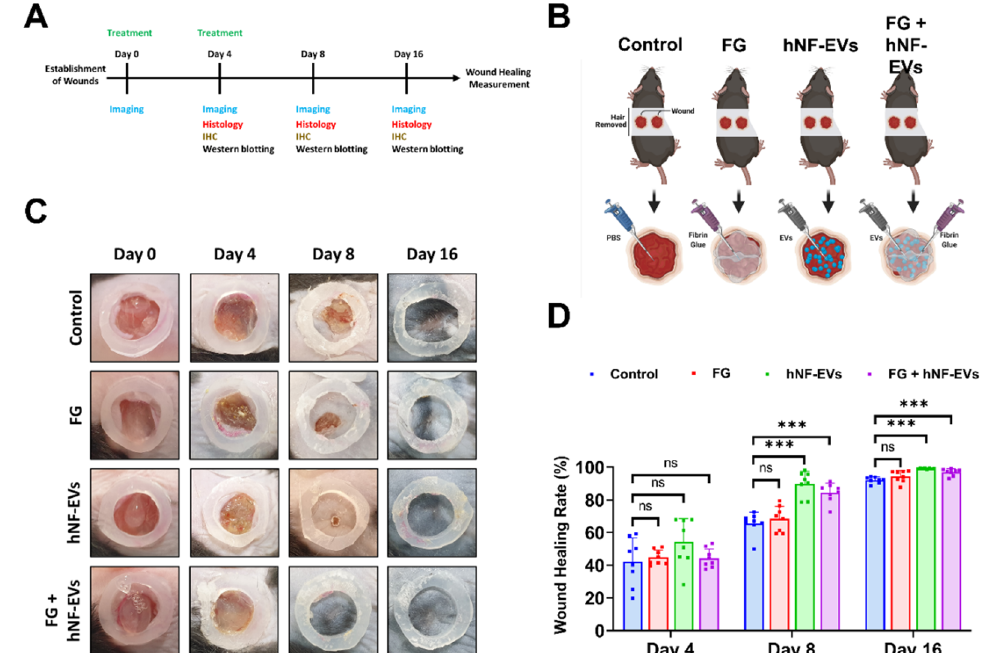
Figure 6. hNF-EVs treatment of accelerated wound-healing in C57BL/6 mice. ( A ) Schematic of in vivo experiments. ( B ) A schematic representation of in vivo treatments (Control: PBS; Fibrin Glue: FG; hNF-EVs; FG + hNF-EVs), created with BioRender.com accessed on 13 April 2021. ( C ) Representative images display the wound healing process of C57BL/6 mice treated with control: PBS; Fibrin Glue: FG; hNF-EVs; FG + hNF-EVs (day 0, 4, 8, and 16). ( D ) Percentage of wound healing in mice treated with control: PBS; Fibrin Glue: FG; hNF-EVs; FG + hNF-EVs (mice = 4 or wounds: n = 8). *** p < 0.001 and ns: not significant. A student’s t -test was used.